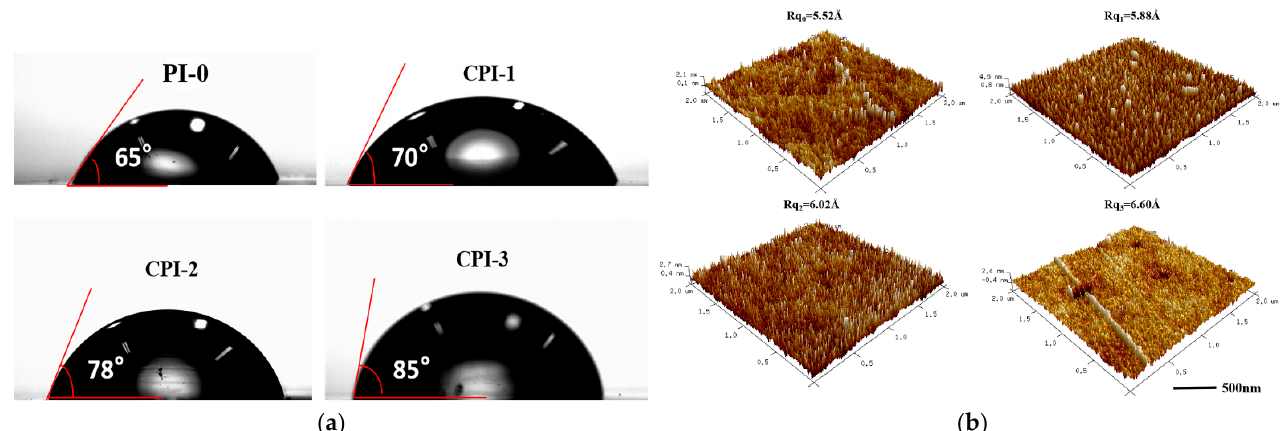
Figure 5. ( a ) Contact angles and ( b ) AFM images of the CPI films.